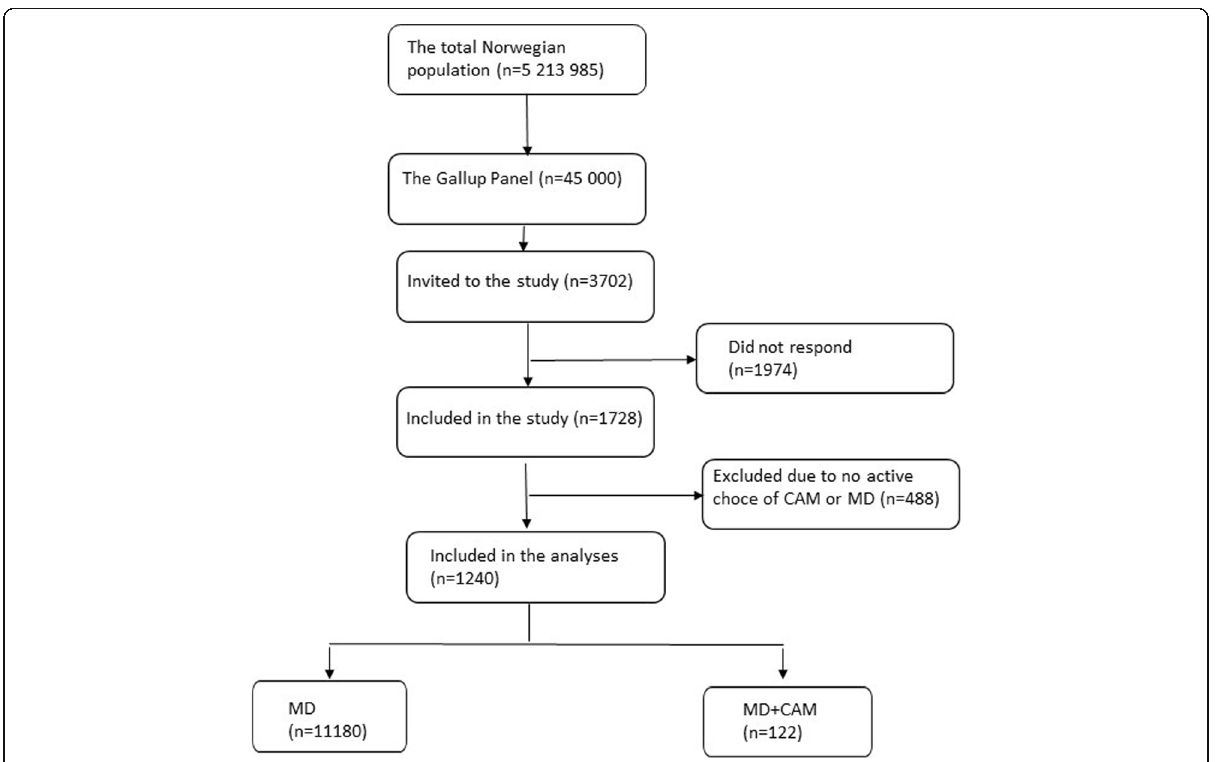
Fig. 1 Flow chart showing the selection of the studied